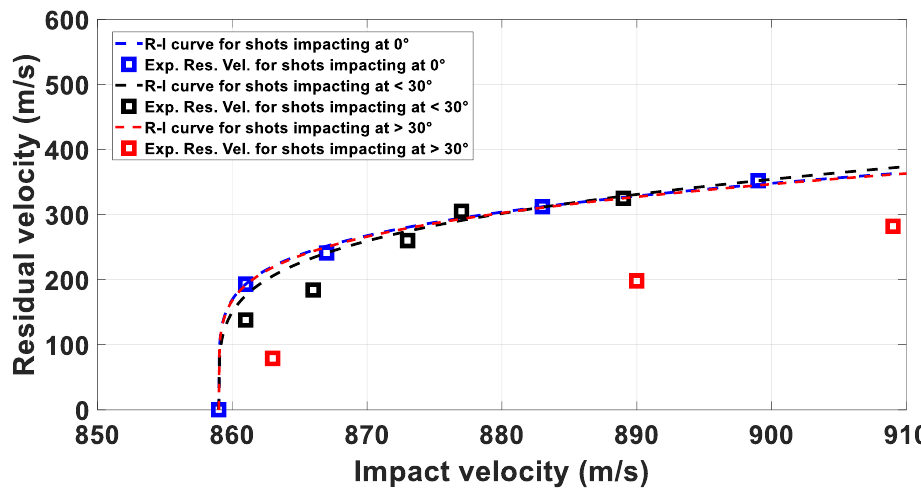
Figure 5. Recht Ipson curves for 5 mm fragments impacting 2 mm plates. In the graph, the blue markers indicate the residual velocities measured for shots impacting the target with 0 degrees, the black markers indicates the residual velocities for impacts at α up to 30° degrees, and the red markers indicate impacts at values of α higher than 30° degrees. A significant effect in the outcomes is evident on the red markers.